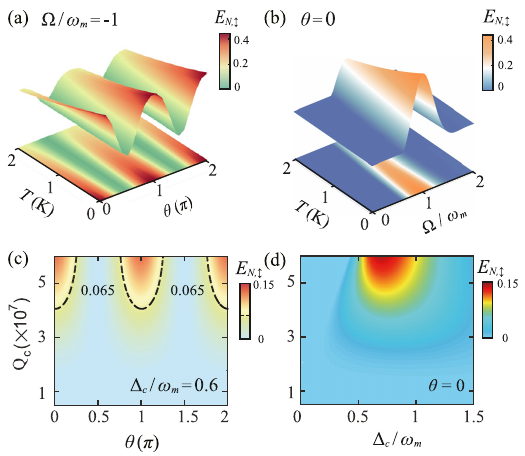
Figure 4: The role of thermal effects and quality factors on the generation and manipulation of COM